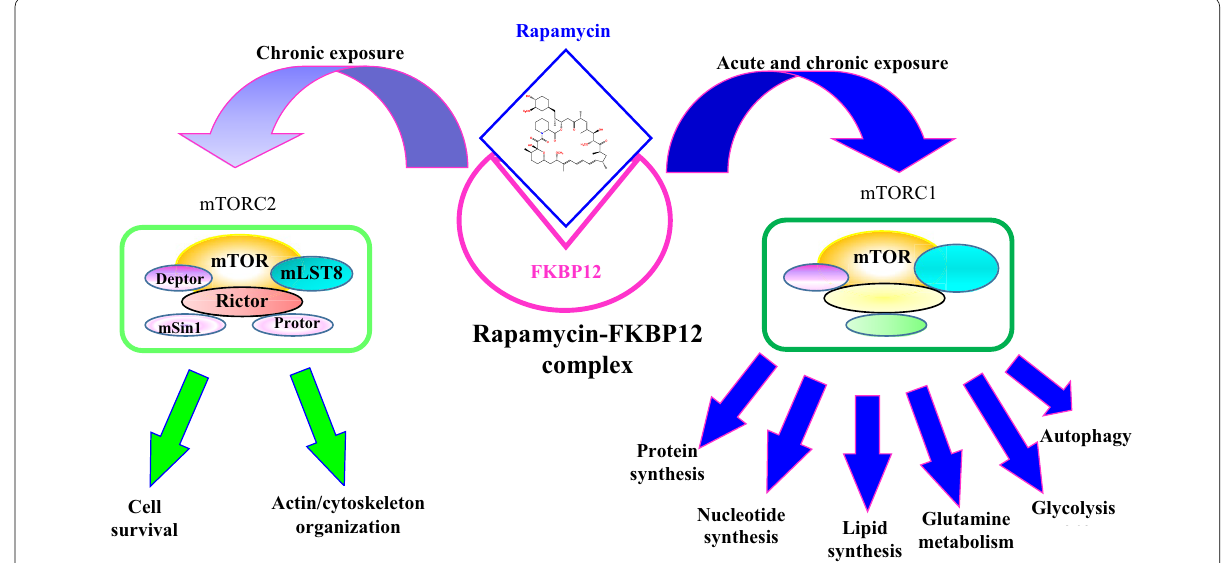
Fig. 4 The two functional mTOR complexes and their role in regulating main cellular